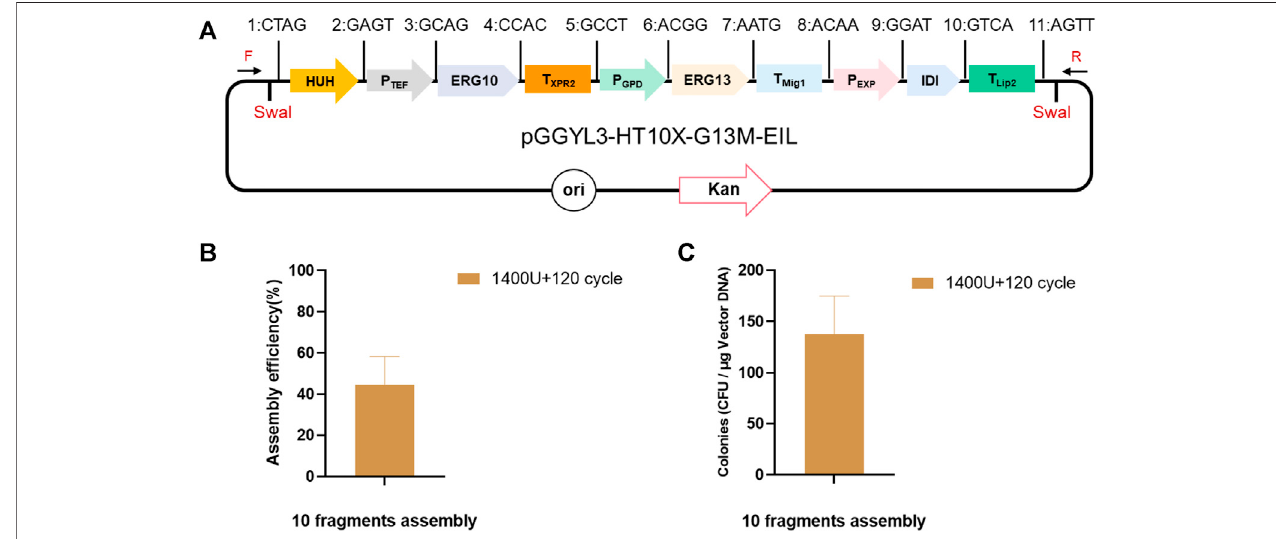
FIGURE4| Assemblyof10fragmentsusingYALIcloneNHEJ. (A) SchematicrepresentationofthecompletelyassembledplasmidpGGYL3-HT10X-G13M-EIL. (B) Assembly ef fi ciency with 1,400 U of T4 DNA ligase and 120 reaction cycles. (C) Number of transformants with 1,400 U of T4 DNA ligase and 120 reaction cycles. The primer F/R was used to amplify the assembled